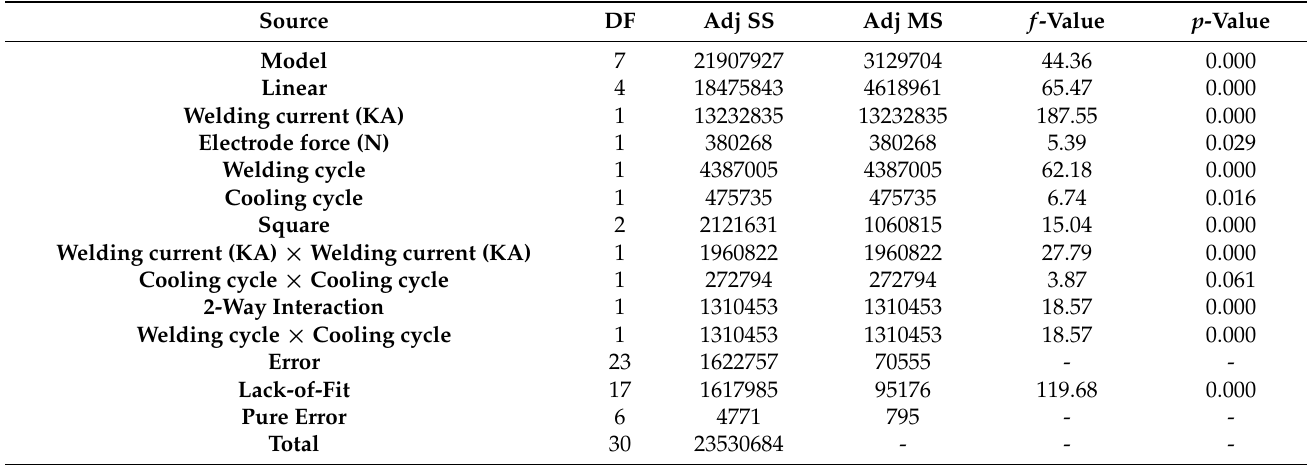
Table 5. ANOVA for TSS of dissimilar joints of AISI 304 and AISI 1060 steels after RSW process.